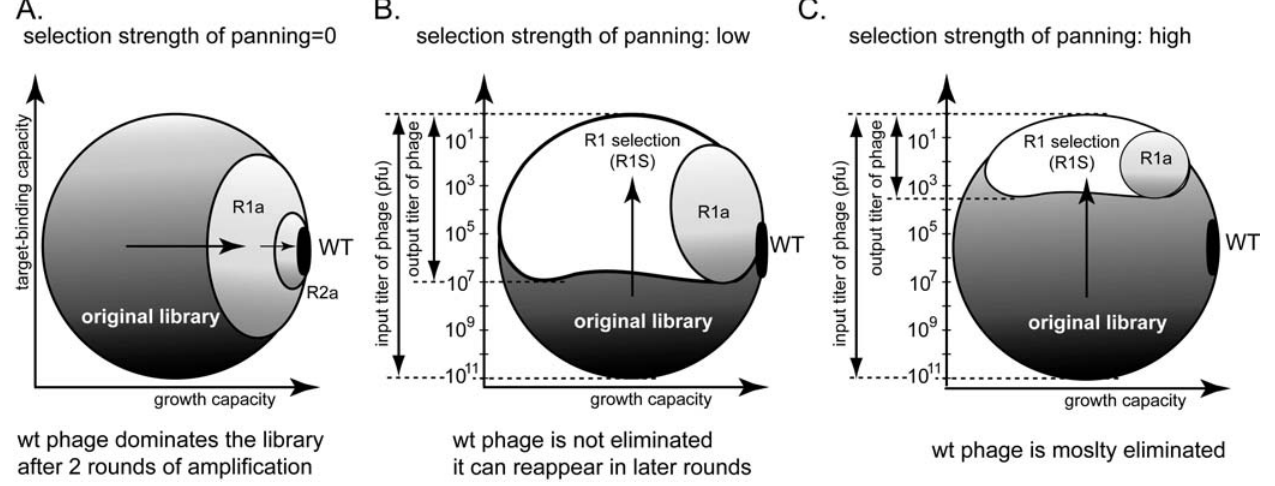
Figure 8. (A-C) Phage phase diagram illustrating that increasing the strength of the selection can minimize amplification of non-specific